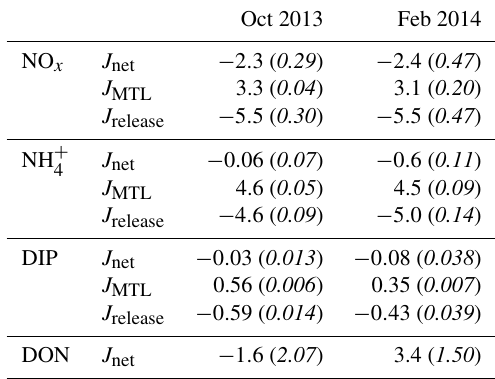
Table 2. Mean (italics indicate standard error) net fluxes (in mmolm − 2 d − 1 ) of nutrients determined by the CoVo approach during the October and February field experiments. Nutrient species include nitrate and nitrite (NO x ), ammonium (NH + solved inorganic phosphorus (DIP), and dissolved organic nitrogen (DON). Mean net ( J net ), mass-transfer-limited ( J MTL ), and release ( J release ) fluxes are from samples taken during the final 6h of ebb tide and do not represent fluxes at all phases of the semidiurnal tidal